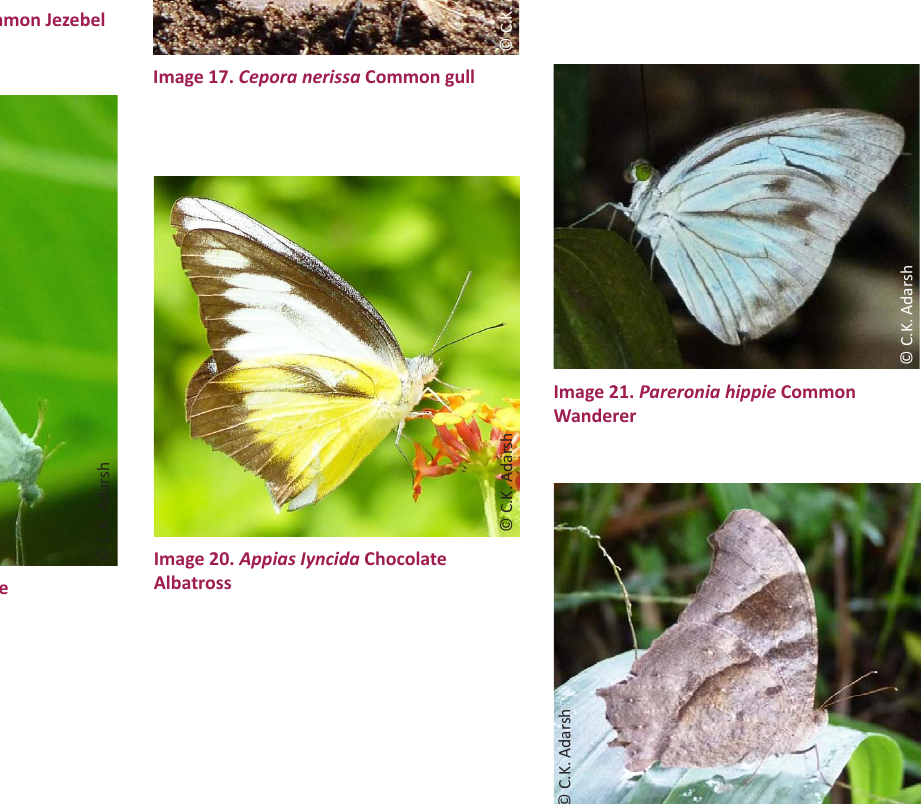
Image 18. Belenois aurota Pioneer